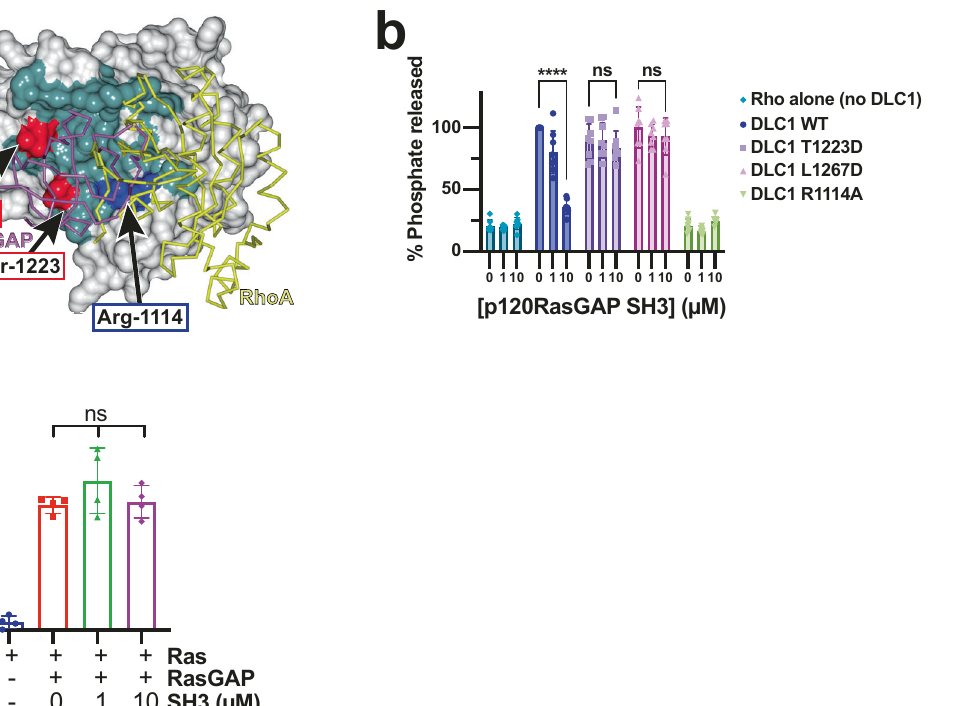
0 μ M versus 10 μ M SH3, P <0.0001; T1223D 0 μ M versus 10 μ M SH3, P =0.7747; L1267D 0 μ M versus 10 μ M SH3, P =0.5663. c GTP hydrolysis by Ras (blue) is sti- mulated by p120RasRasGAP RasGAP domain (red) but is not inhibited by 1 μ M (green) or 10 μ M (purple) p120RasGAP SH3 domain. Data are presented as mean values (bars) +/ − SD (error bars), and individual measurements are plotted (dots, n =4). P values are:0 μ M versus 1 μ M SH3:0.3148;0 μ M versus 10 μ M SH3: 0.9944; 1 μ Mversus10 μ MSH3:0.4329.In b , c P valueswerecalculatedbyordinaryone-way ANOVA analysis with Tukey ’ s multiple comparison test in GraphPad Prism. Sig- ni fi cant differences are based on P values as indicated: ns: P ≥ 0.05; **** P <0.0001. Source data are available as a Source Data fi